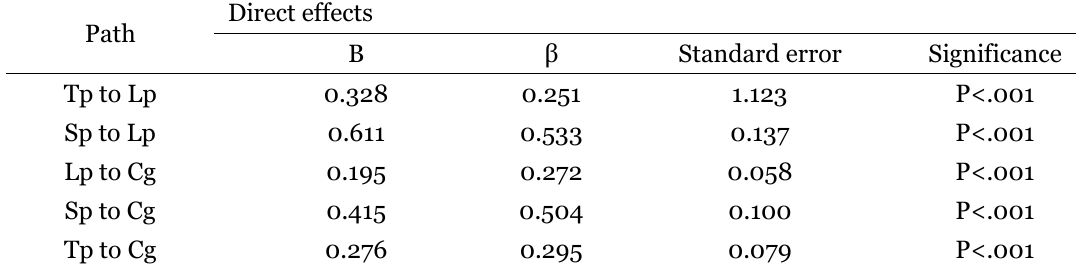
Results of the Path Analysis